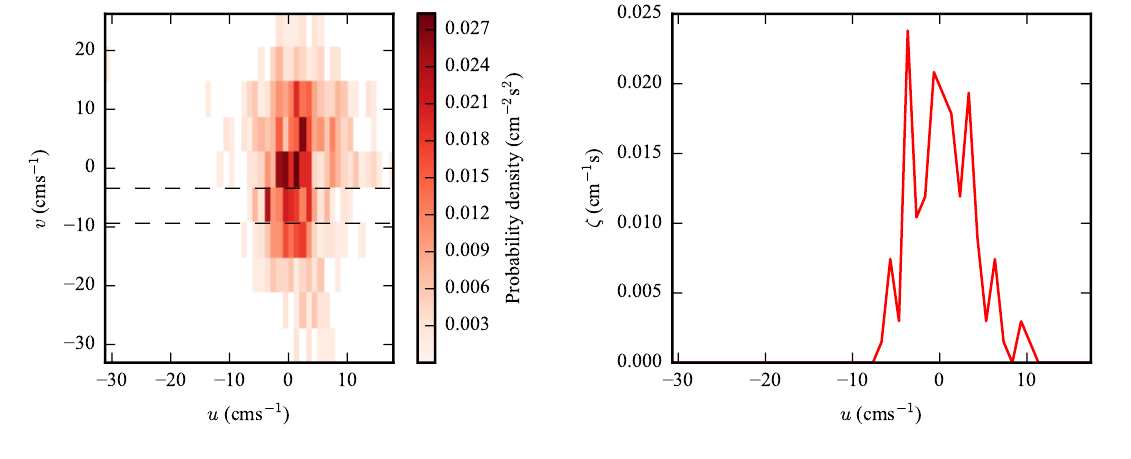
Figure A2. Probability density calculated from tidal current velocities ( u and v ) measured at the NOAA Cherry Point monitoring station (data shown in Figure A1). The ’slice’ shown in (b) is extracted from the data between the dashed lines in (a).